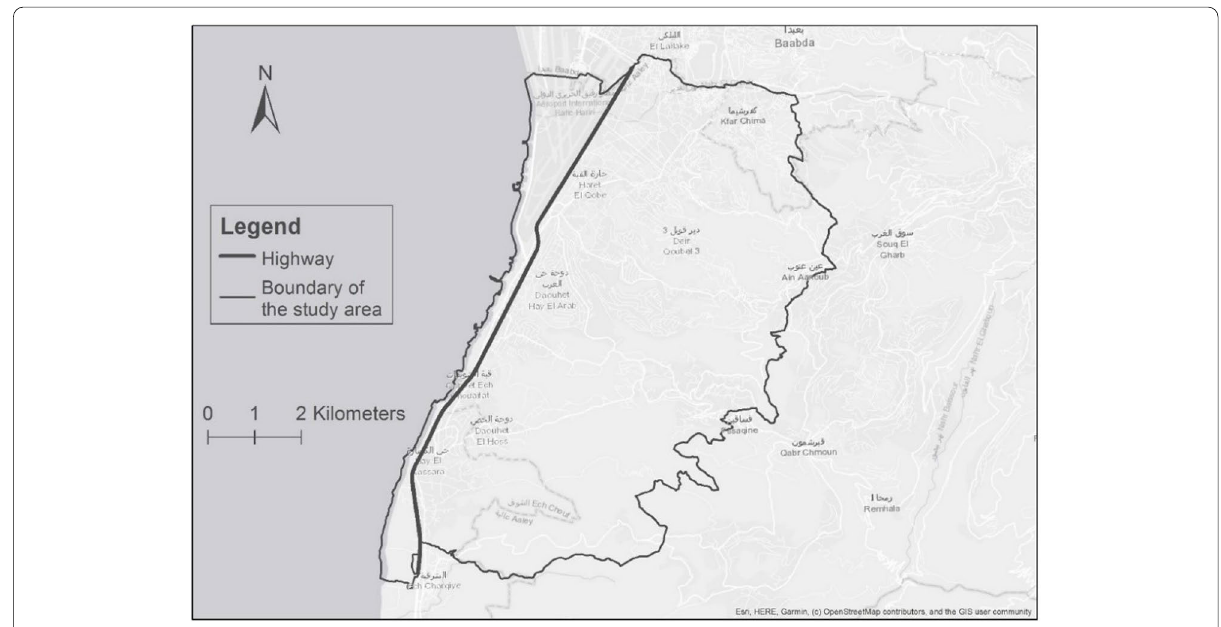
Fig. 2 The geometrical boundary of the study